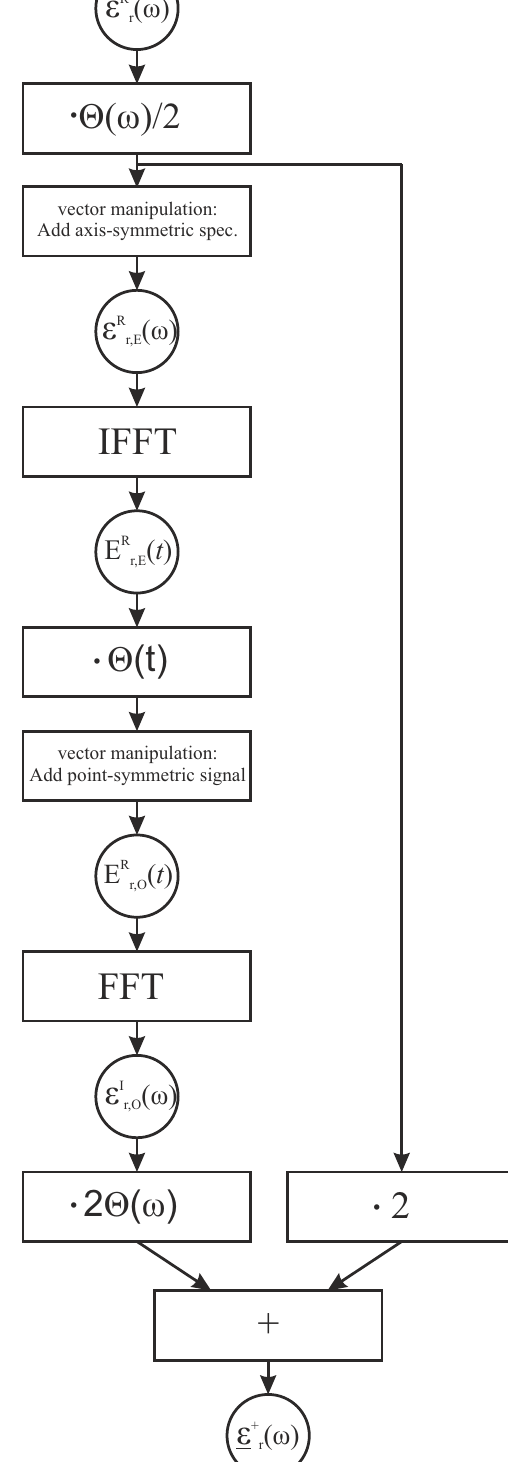
Figure 3. Processing steps of the complex valued completion (CVC). While rectangular boxes describe signal operation, circles indicate the current signal form. The applied function Θ indicates the heaviside function in frequency-domain ( ω ) and time-domain ( t